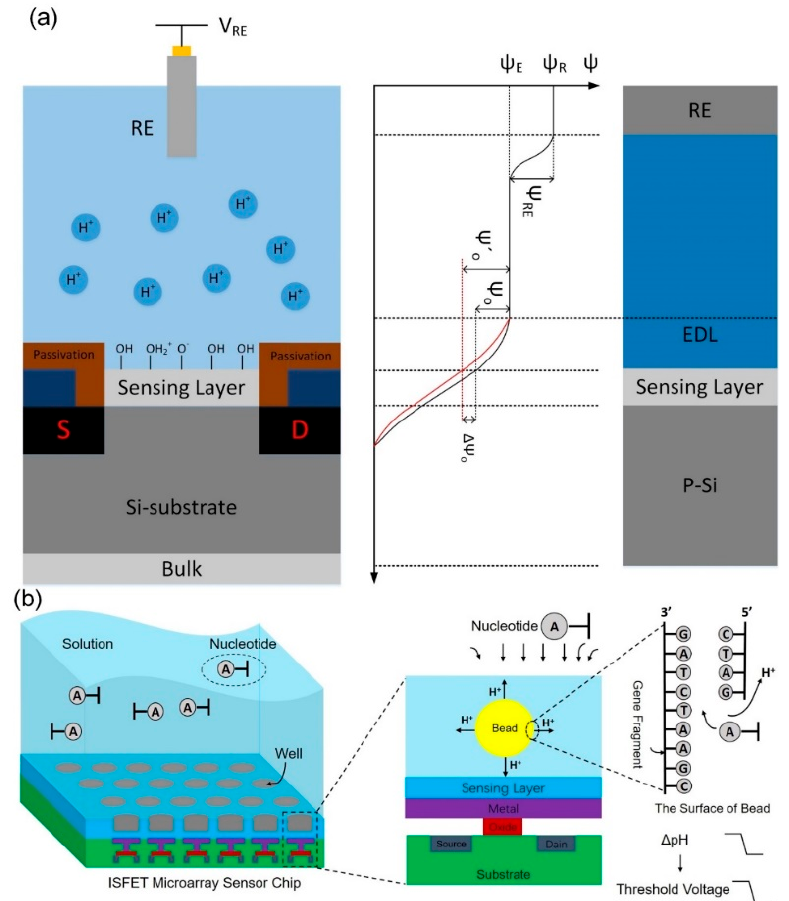
Figure 1. Principles of semiconductor gene sequencing. ( a ) The pH-ISFET structure and working principle, when the pH value in the solution changes, the threshold voltage of the ISFET also changes. ( b ) Sequencing of steps: The long gene chain is cut into small single fragments, which are duplicated, amplified and attached to the microbeads; the microbeads are then distributed into the wells on the surface of the ISFET sensor chip; four kind of nucleotides are supplied in preset order, and when a nucleotide is incorporated into a strand of DNA by a polymerase, a hydrogen ion is released as a byproduct; ISFET sensor senses changes in pH, and the gene sequence then could be obtained.